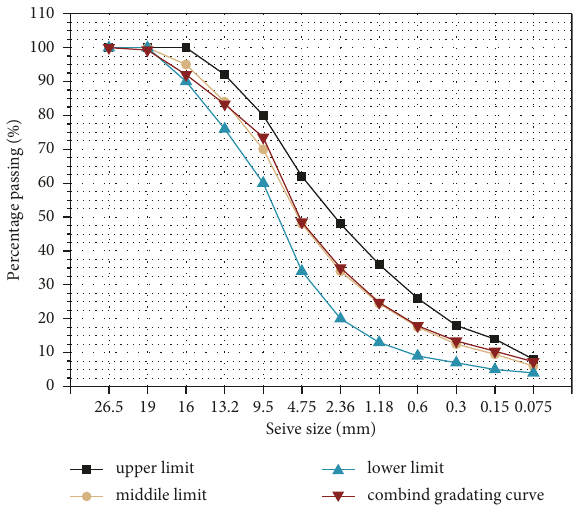
Figure 3: Gradation of the